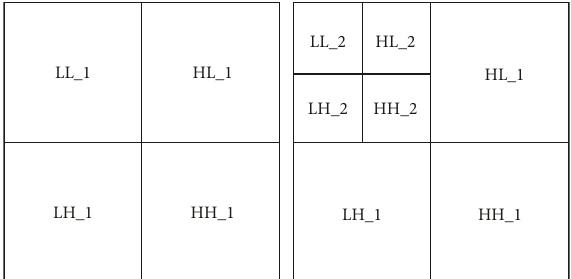
Figure 8: 1-level DWT and 2-level DWT.